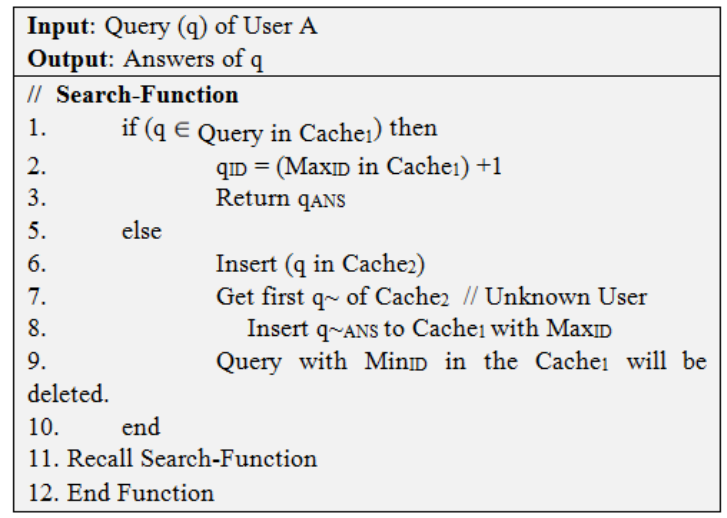
Figure 13. Algorithm 1 of IBPs.